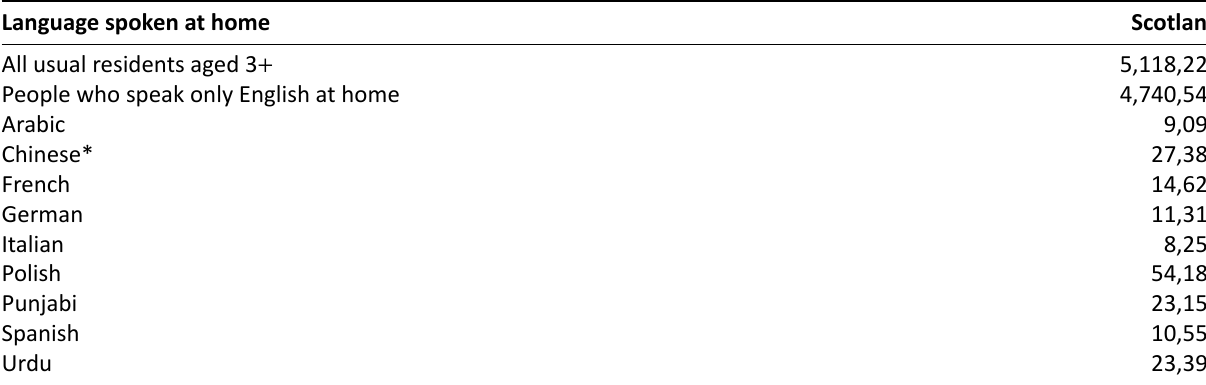
Table 1. 2011 Scottish Census: Language spoken at home (NRS, 2015). Language spoken at home All usual residents aged 3